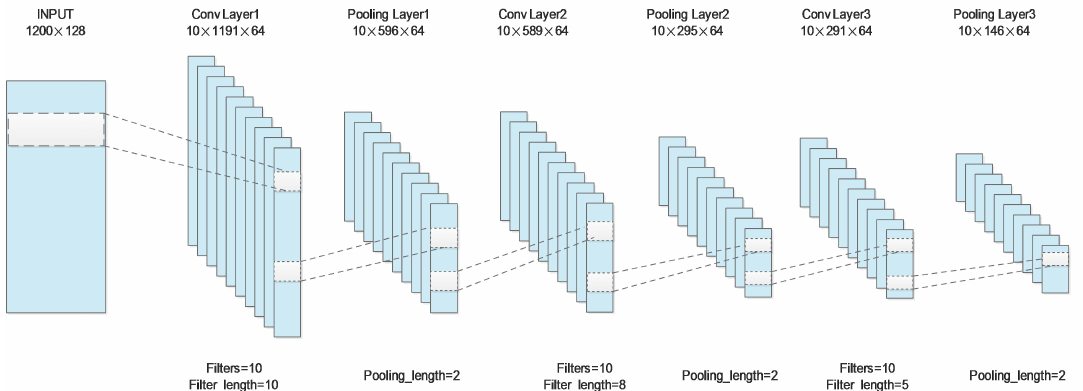
Figure 2. The architecture of convolutional neural network (CNN)